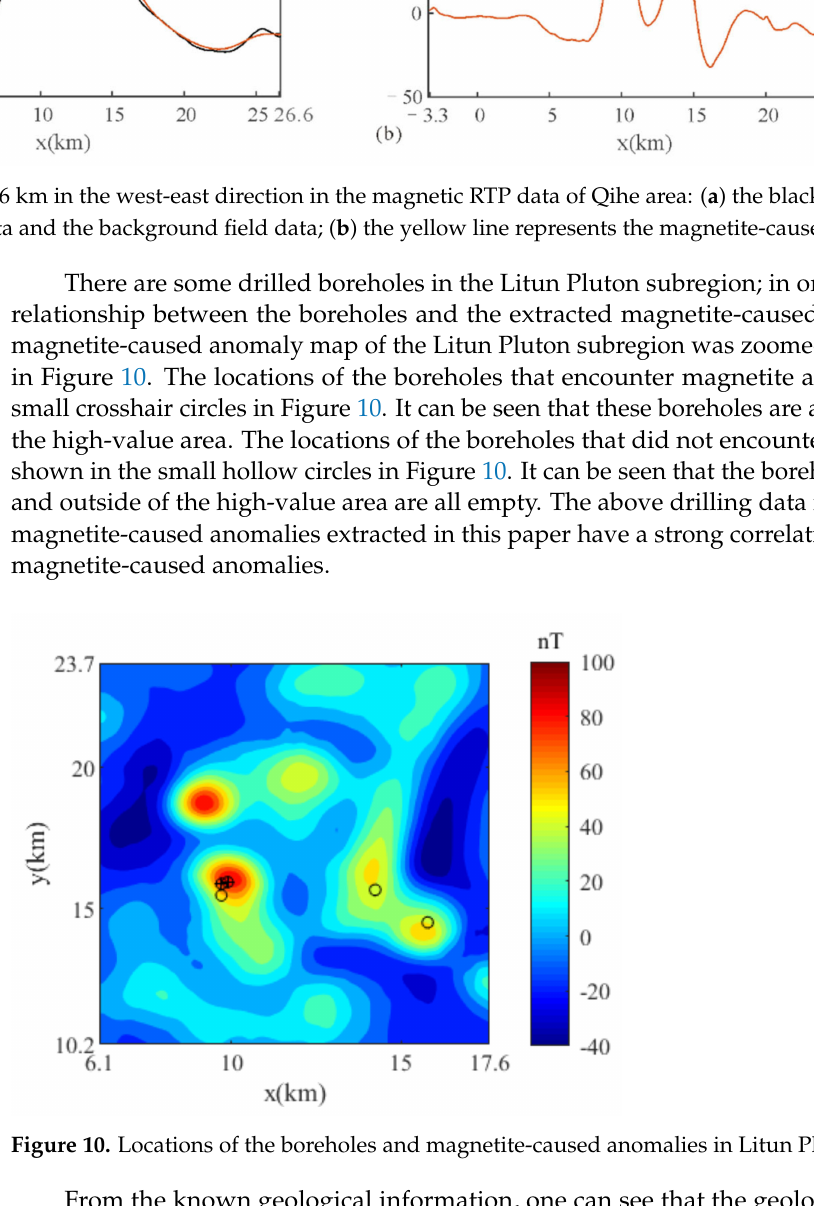
logenic conditions are different in the different subregions in the study area [55,56]. We divided the survey area into three subregions—Litun Pluton subregion (Figure 11a), Pan- dian Pluton subregion and Dazhang Pluton subregion—according to the existing geological data and magnetic RTP data. In this way, Inversion parameters can be set more specifically according to the characteristics of different